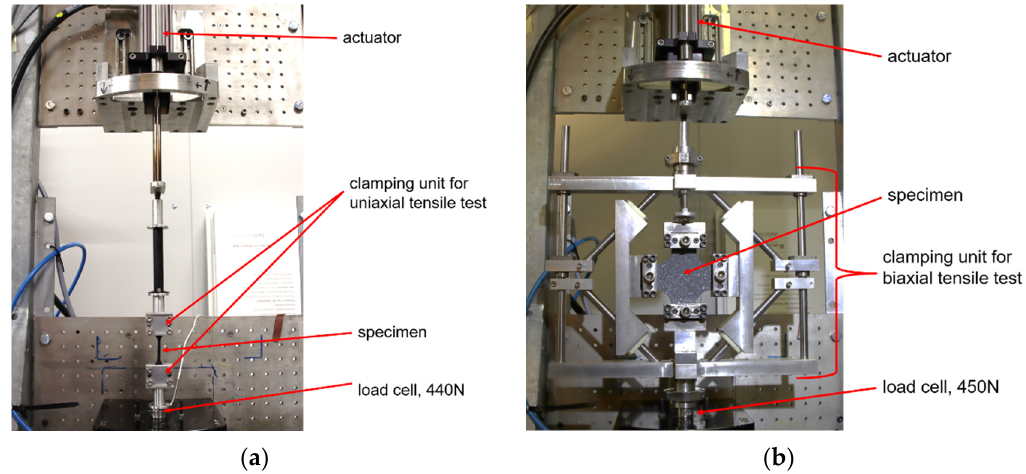
Figure 15. Experimental test-setups for: ( a ) uniaxial testing and ( b ) biaxial testing.